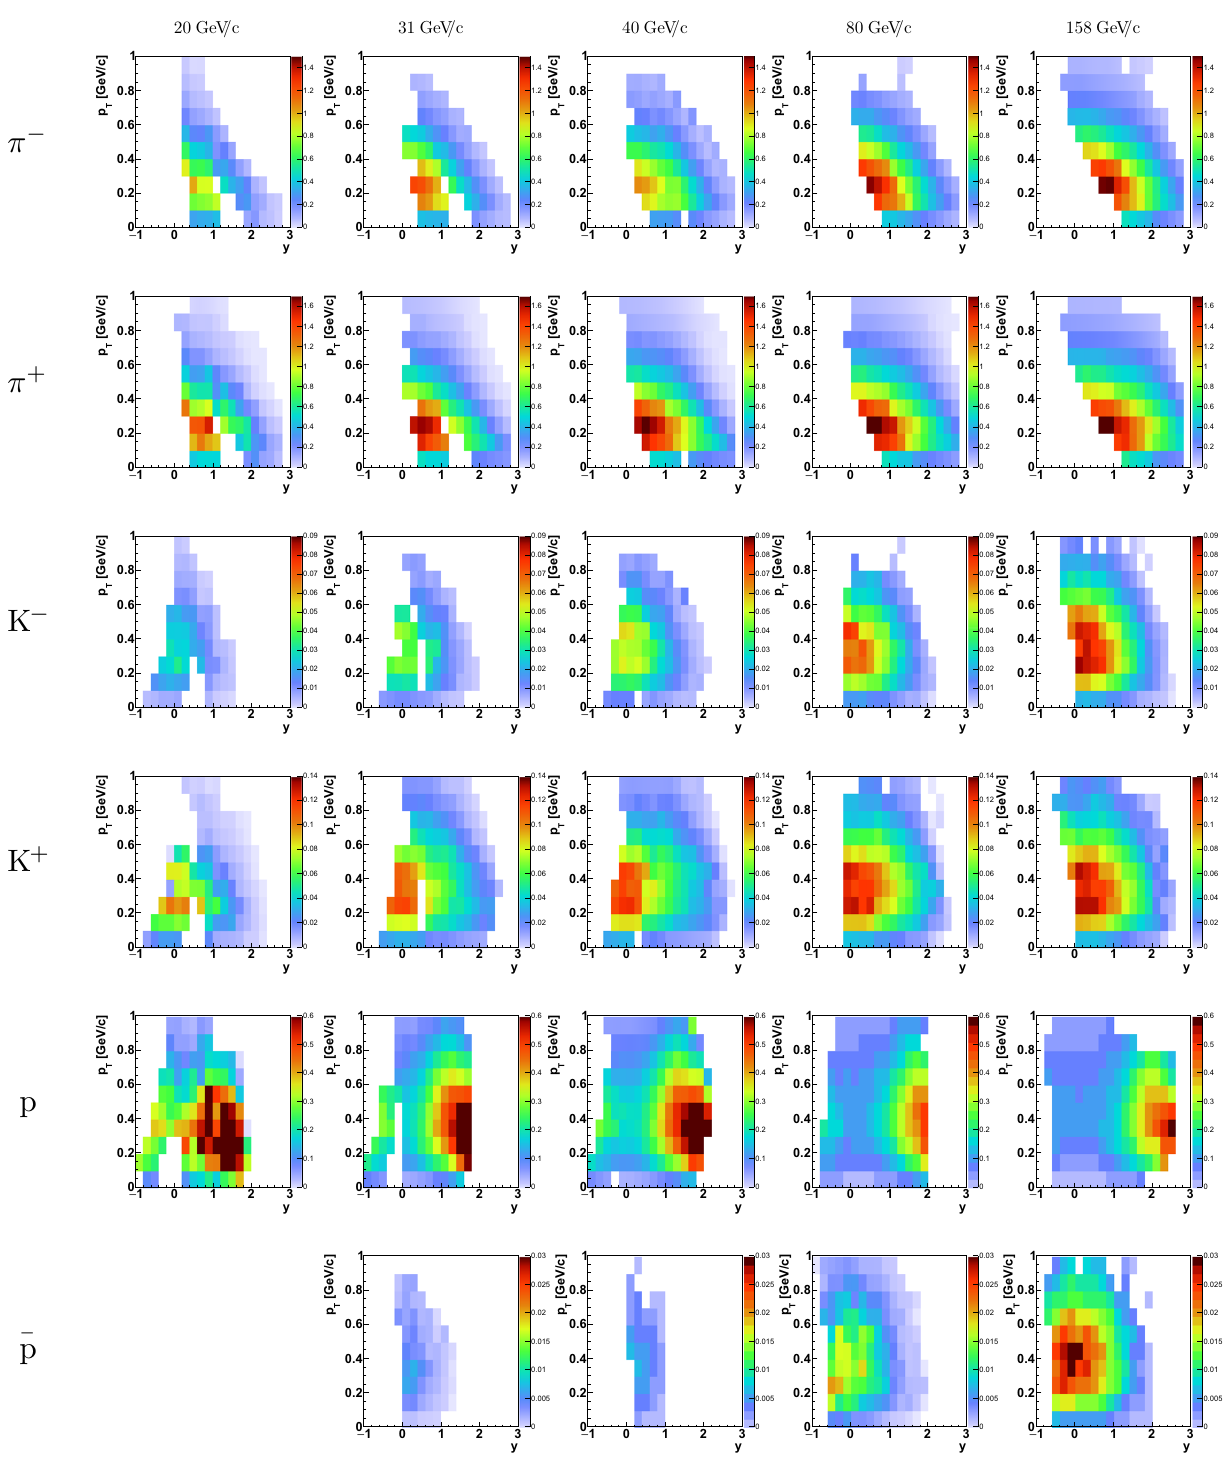
Fig. 25 Transverse momentum-rapidity spectrum of π − , π + , K − , K + , p and ¯ p produced in inelastic p + p interactions at 20, 31, 40, 80 and 158 GeV / c . Color scale represents particle multiplicities normalized to the phase-space bin size ( dn variable. For example particles in bins selected for the iden- tification ( p lab ) may not fully populate the edges of bins in the final variable (y) due to the non-orthogonal transforma-